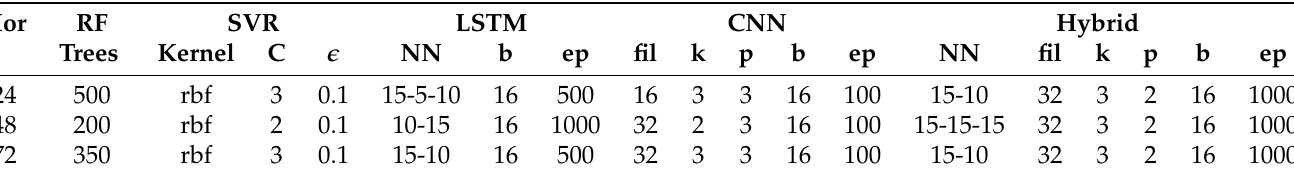
Figure 11. RMSE comparison for differet horizons: ( a ) one, ( b ) two, and ( c ) three days ahead, respectively. Table 3. Best ML-method hyperparameter tunning.